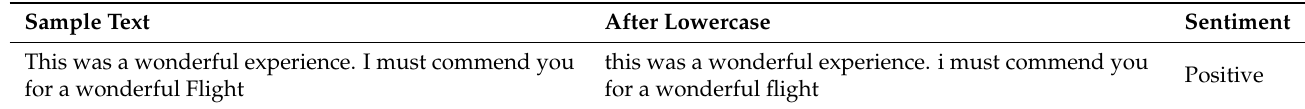
Table 3. Outcome of lower-case transformation.